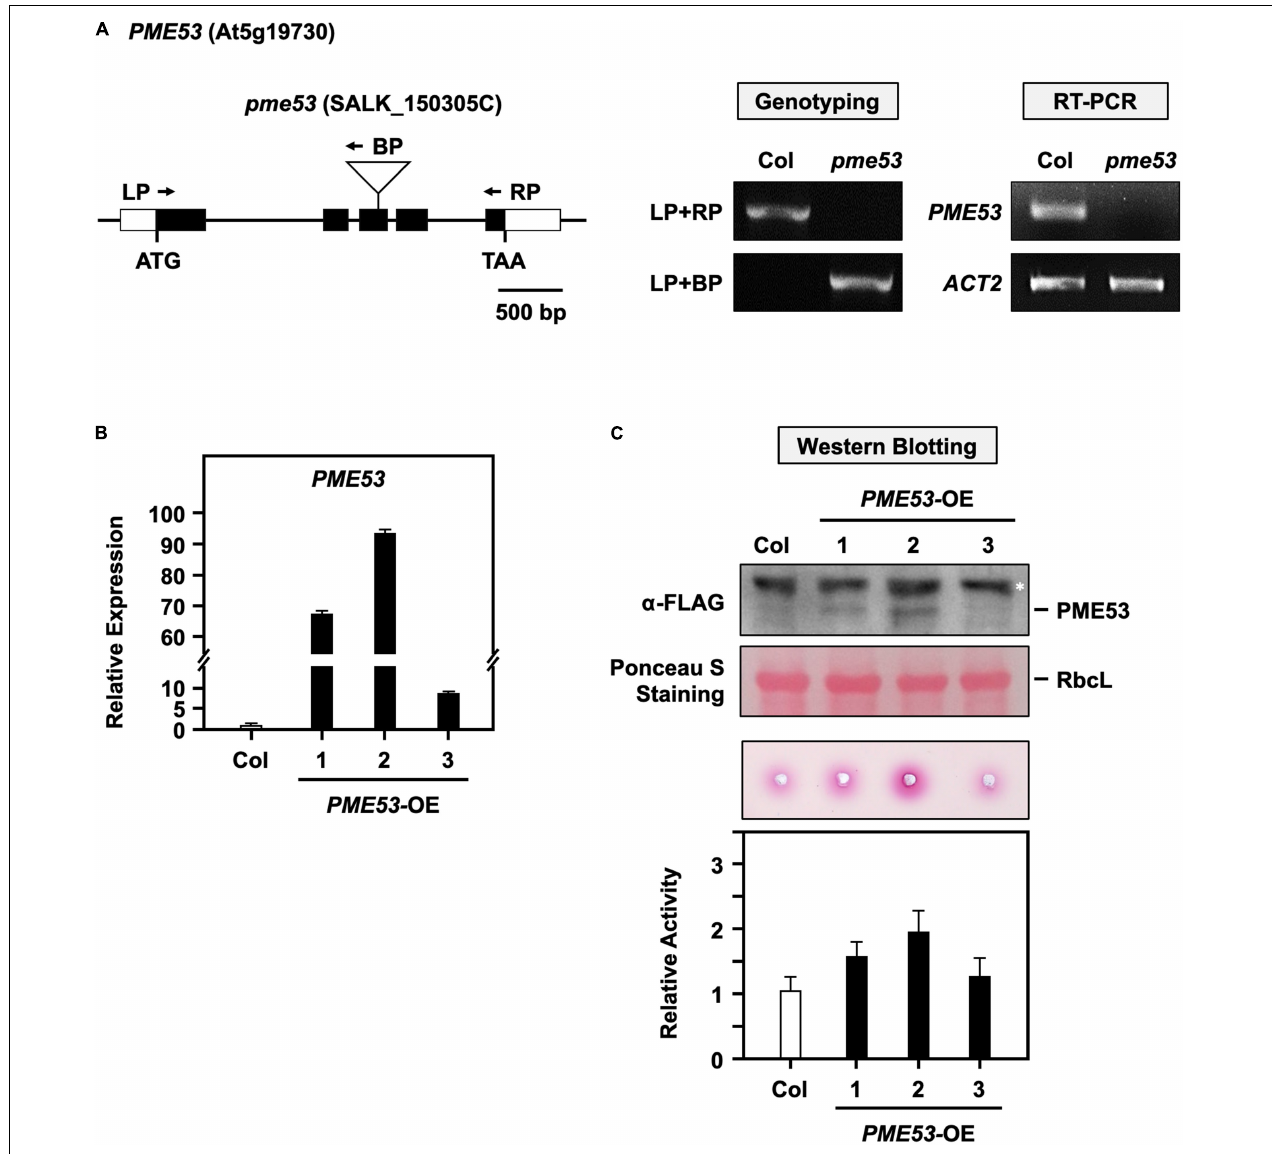
FIGURE 2 | Characterization of PME53 T-DNA insertion and its overexpression lines. (A) Schematic map of PME53 gene and T-DNA insertion site. The white box, black box, and solid line indicate the UTR region, exon, and intron, respectively. ATG are shown as initiation codons. T-DNA insertion site is indicated as triangle, and primers for genotyping are indicated as arrows. RT-PCR involved the PME53 gene-specific primers. Actin2 ( ACT2 ) was used as an input control. (B) The expression levels of PME53 in three independent lines, PME53 -OE1 to OE3, were analyzed by q-PCR. The fold change expression was normalized relative to level of the Col. (C) 7-day-old seedlings were used for PME53 protein level (top) and activity (bottom) analysis. Immunoblot stained with Ponceau S and the ribulose bisphosphate carboxylase large subunit (RbcL) was as a loading control. Western blotting analysis using anti-FLAG antibody. *Indicates non-specific immune signals. The fold change PME activity was normalized relative to level of the Col.